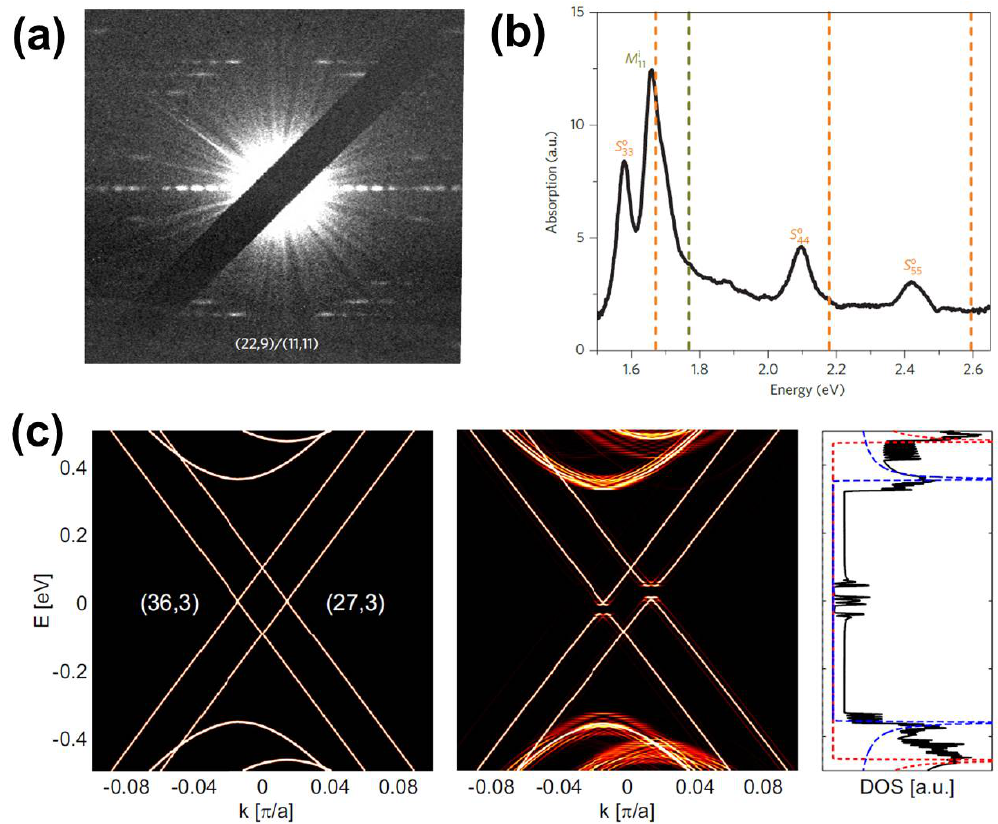
Figure 4. ( a , b ) The electron diffraction pattern of a ( 11,11 ) @ ( 22,9 ) DWNT and the absorption spectrum of the same DWNT, respectively. The dashed lines in ( b ) show the expected emission for the constituting SWNTs, and when compared to the experimental data, it is evident that the DWNT emissions are all redshifted. Reproduced with permission from [55], Copyright Nature Publishing Group, 2014. ( c ) Theoretical calculations showing the energy bands for a ( 27,3 ) @ ( 36,3 ) DWNT that presents Moir´ e patterns. The left panel shows the energy bands for each constituent SWNT without the influence of interlayer (IL) interactions. The middle panel shows the changes in the energy bands when the IL interactions are present. The right panel shows the DWNT density of states (DOS). The dotted red (blue) lines are DOS for inner (outer) nanotubes and the solid black line is the DOS for the coupled DWNT. Reproduced with permission from [54], Copyright American Physical Society,